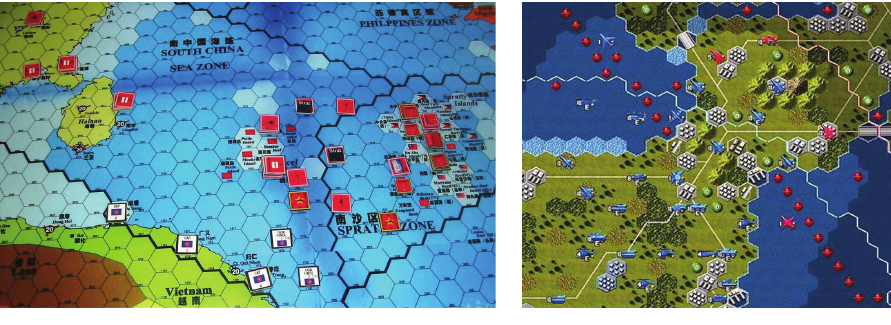
Figure 1: Wargaming and SLG game.